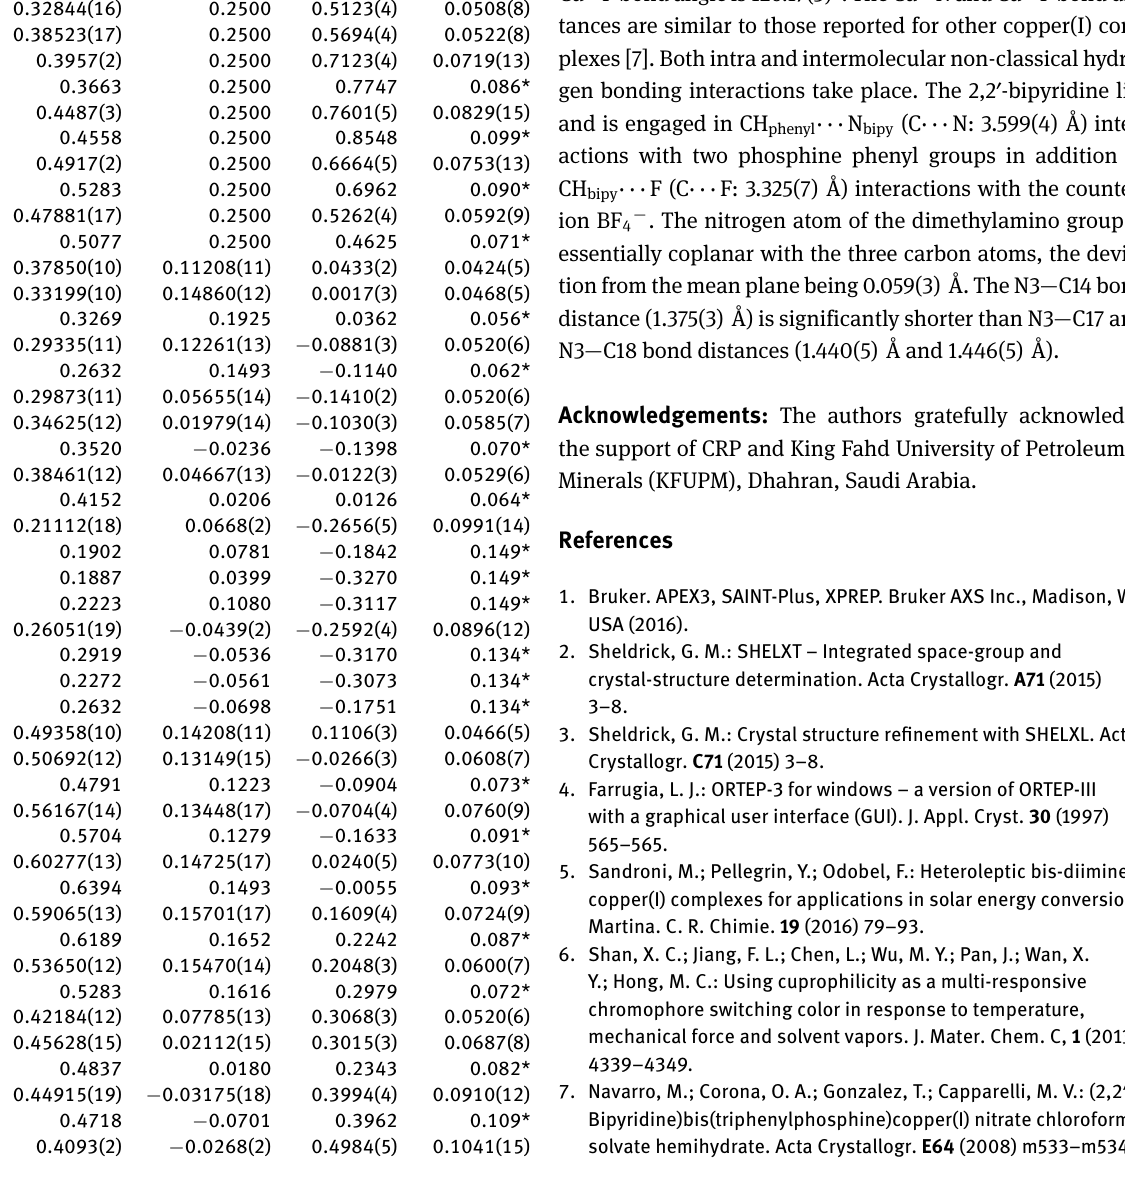
plexes [7]. Both intra and intermolecular non-classical